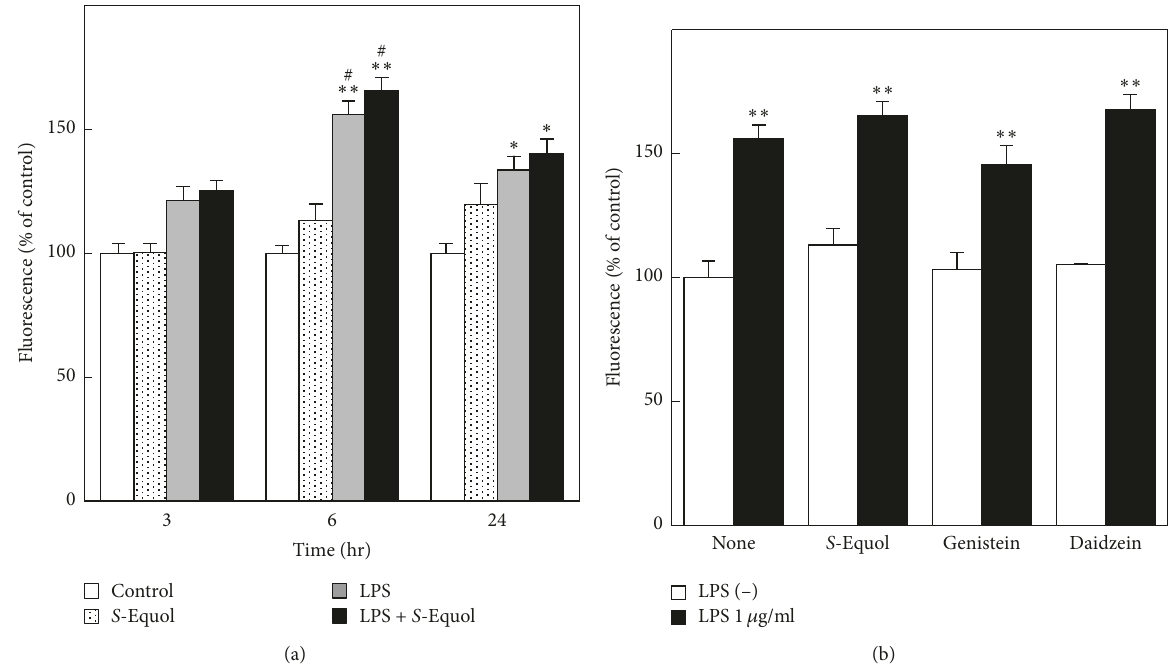
Figure 4: Effect of S -equol on LPS-induced ROS production. Cultured astrocytes were treated with LPS (1 𝜇 g/ml) in the absence or presence of 50 𝜇 M S -equol for 3, 6, and 24h, and the intracellular ROS levels were evaluated using the DCFDA method (a). Effect of isoflavones ( S - equol, genistein, and daidzein, each concentration of 50 𝜇 M) on LPS-induced ROS production at 6h after LPS treatment (b). Data are the mean ± SEM of 5 samples. ∗ 𝑝 < 0.05 ; ∗∗ 𝑝 < 0.01 significantly different from the nontreated control. # 𝑝 < 0.05 significantly different from S